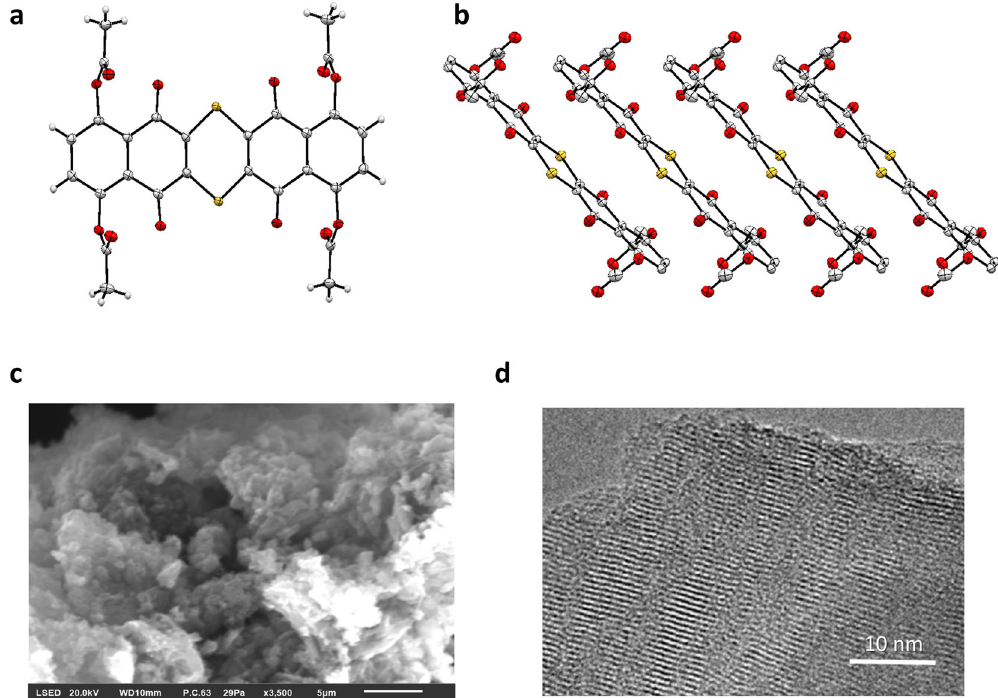
Fig. 3 Characterization of some dimeric derivatives. a , b , ORTEP drawing of the acetyl-protected precursor ( a ) and its stacked structure ( b ). Crystal system: monoclinic; Space group: I 2/ a (No. 15); a : 20.9463(3) Å ; b : 4.77582(6) Å ; c : 24.9250(4) Å ; β :91.3017(12)°; Z : 4; R ( I >2 σ ( I )) : 2.61%; R (all) : 2.80%; wR K α ; Re fl ection: 7450; T : − 173 °C. c , d , Wide fi eld SEM ( c ) and high resolution TEM ( d ) images of the powder of 2 . (all) : 7.10%; GOF: 1.070; Radiation: Cu